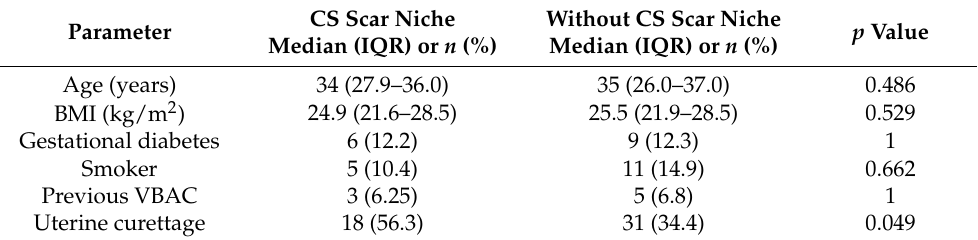
Table 6. Influence of demographic and obstetric variables on CS niche development in a subse- quent